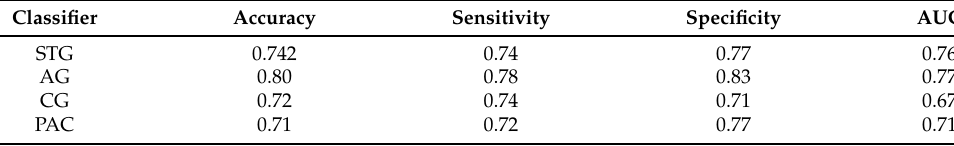
Figure 5. ROC curves and AUC for STG, CG, AG, and PAC selected areas. Table 3. Accuracy, sensitivity, specificity, AUC of selected ROIs.